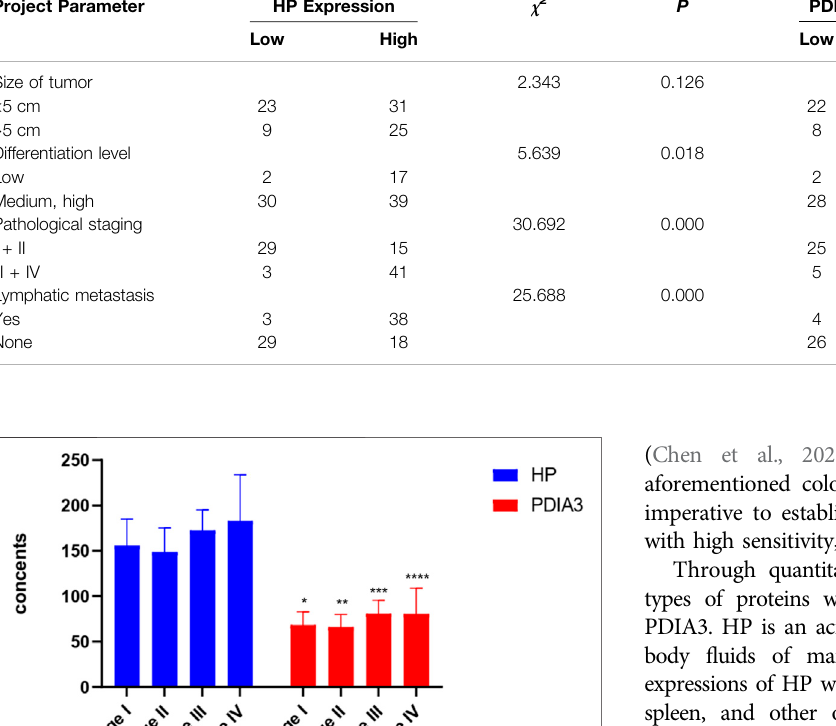
TABLE 3 | Relationships between HP and PDIA3 expressions and colorectal pathological characteristics. Project Parameter